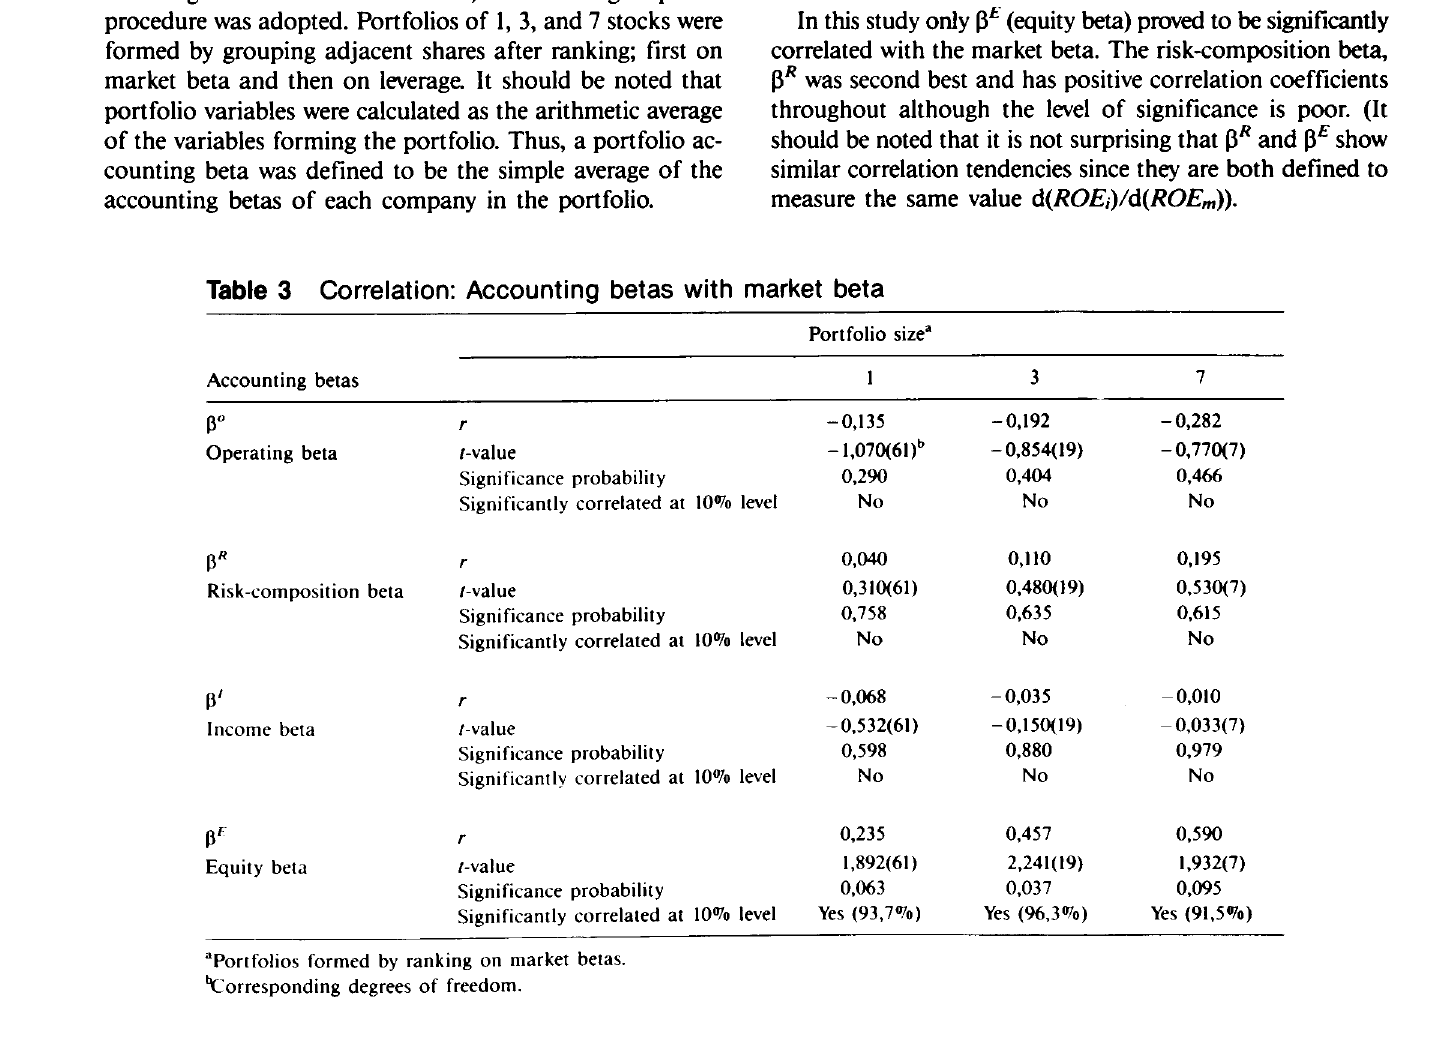
Correlation: Accounting betas with market beta